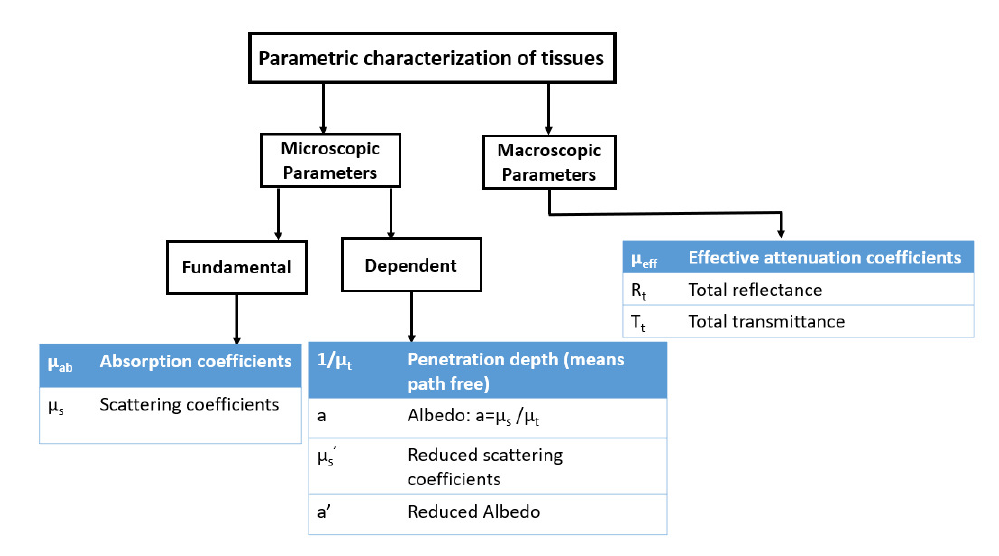
Figure 1. Parametric characterization of tissues on microscopic and macroscopic levels